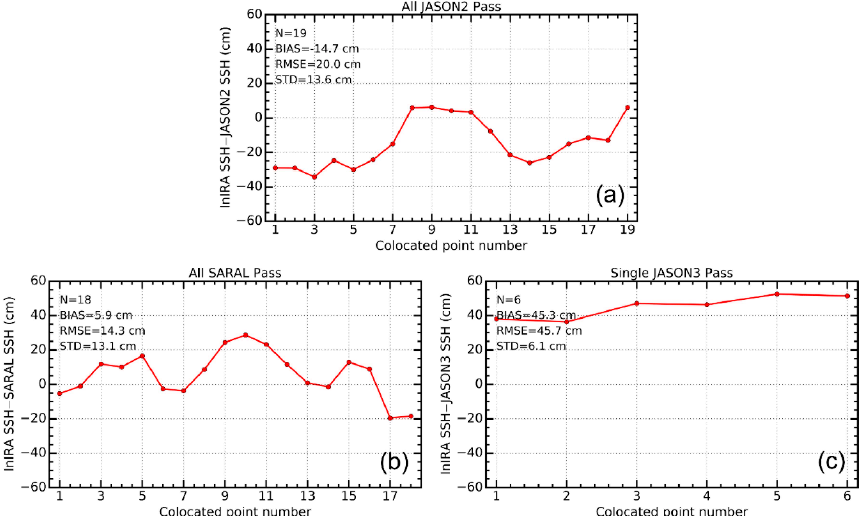
Figure 4. Sea surface height ( SSH) comparisons between the Interferometric Imaging Radar Altimeter (InIRA) and each type of traditional altimeter, ( a ) for all Jason-2 passes, ( b ) for all Saral / AltiKa passes, and ( c ) for a single Jason-3 pass.